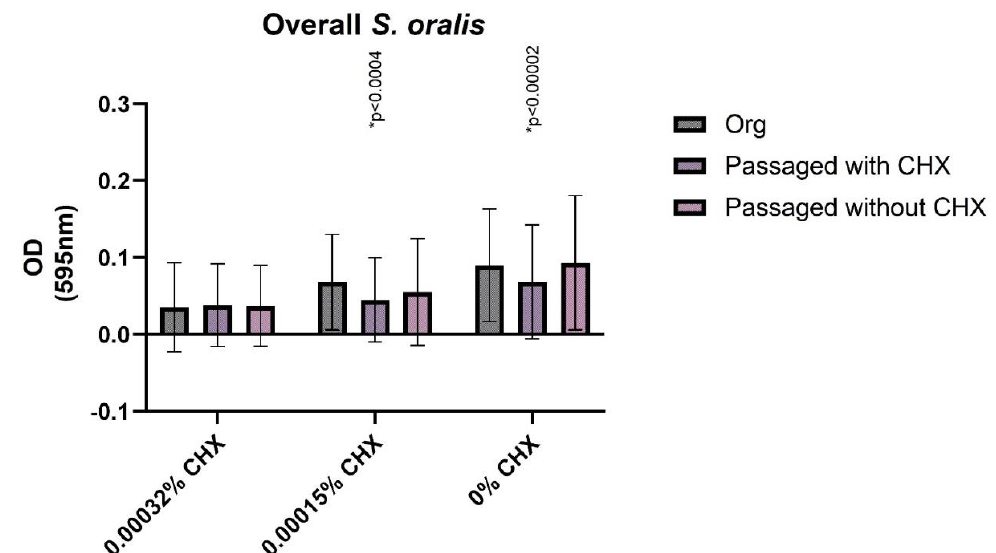
Figure 3. Biofilm formation at different subinhibitory concentrations of chlorhexidine (CHX). Graphical illustration of the biofilm formation (OD values) of S. oralis isolates exposed to subinhibitory concentrations of CHX. The percentages of CHX are shown on the X -axis, and the OD values are shown on the Y -axis. p -values in comparison to the original isolate (* significant difference).